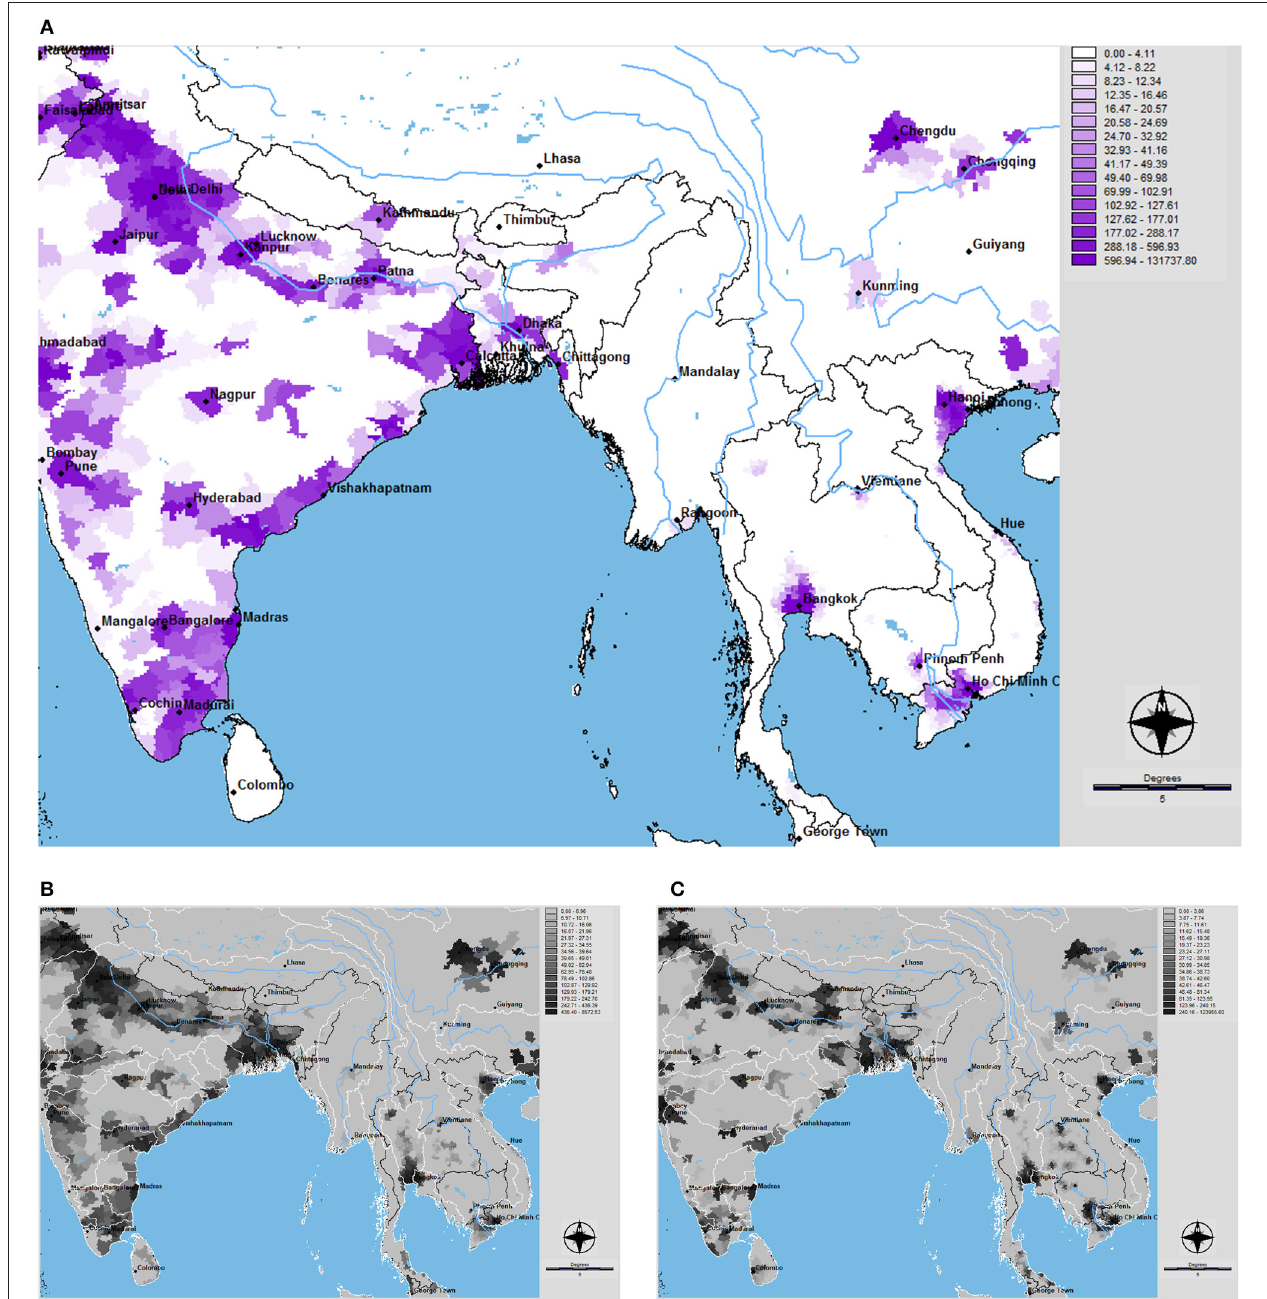
FIGURE 5 | Top (A) : Current value added generated by water (in US $) per pixel ( ∼ 80 km 2 ) at the GAUL 2 level of administrative units; bottom left (B) : value added from the agricultural sector; bottom-right (C) : value added from industrial and service